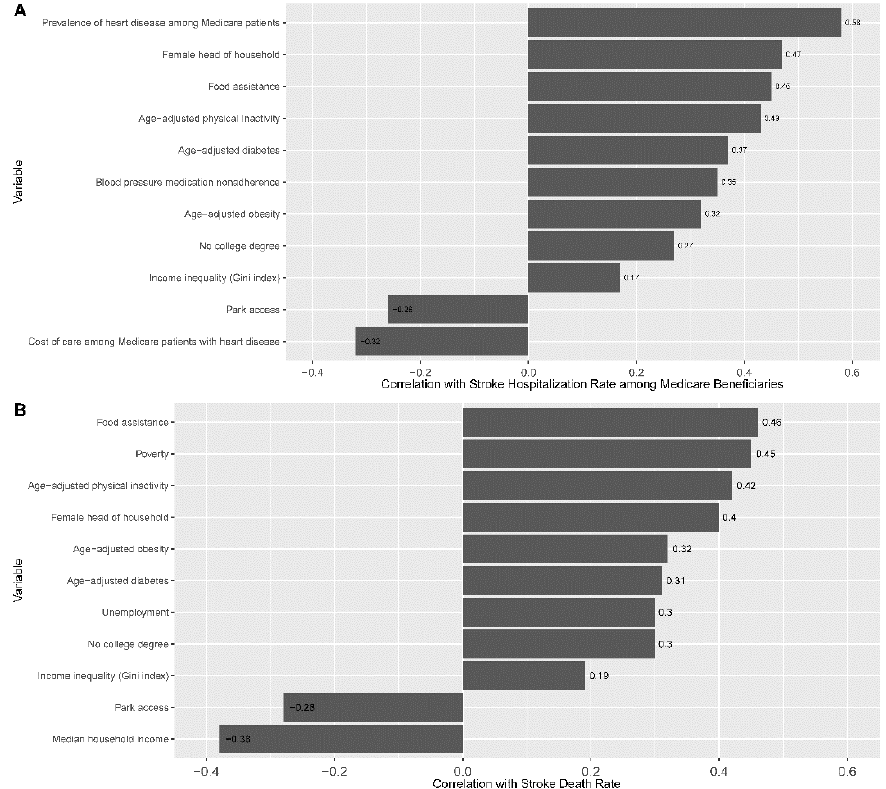
Figure 1. Correlation of continuous variables with outcome variables. ( A ) Correlation of continuous variables with stroke hospitalization rate (SHR) per 1000 Medicare beneficiaries, 65+, all races/ethnicities, both genders; ( B ) correlation of continuous variables with stroke death rate (SDR) per 100,000, all ages, all races/ethnicities, both genders.